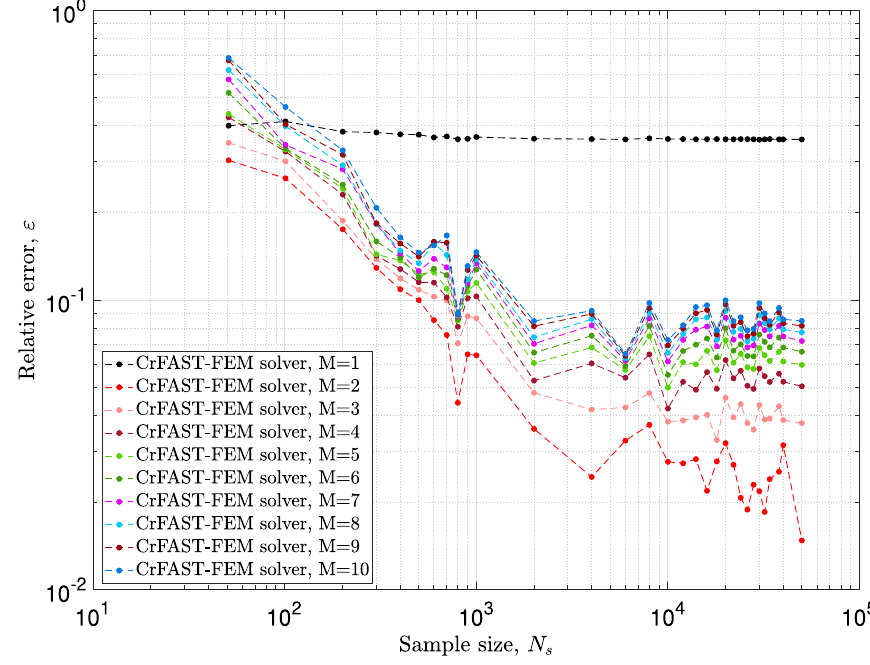
Fig. 9 The effect of the order of the harmonies, M , on the error of Eq. (40) taking into account the correction process introduced by Eq.